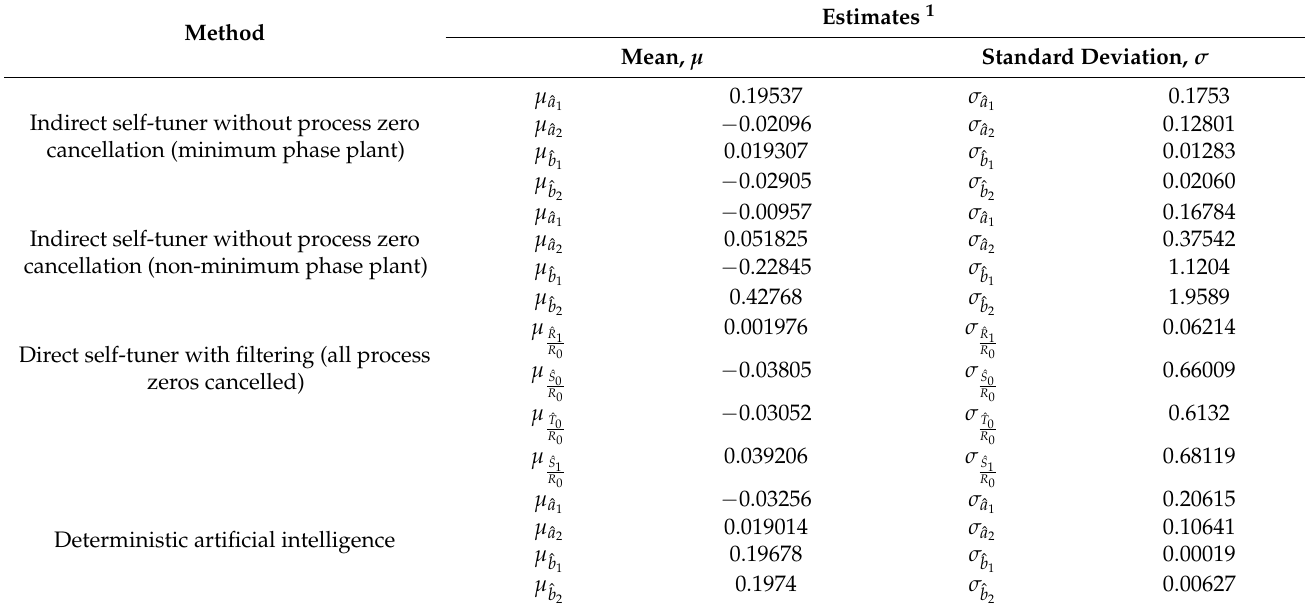
Table 1. Coefficient estimation accuracy of all four methods investigated.